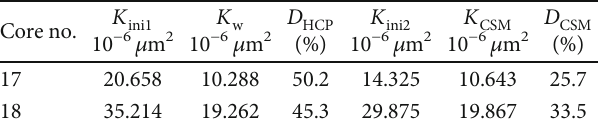
Table 6: HCF and CSM Damage Test Results of the Optimized HFF. K Core no.